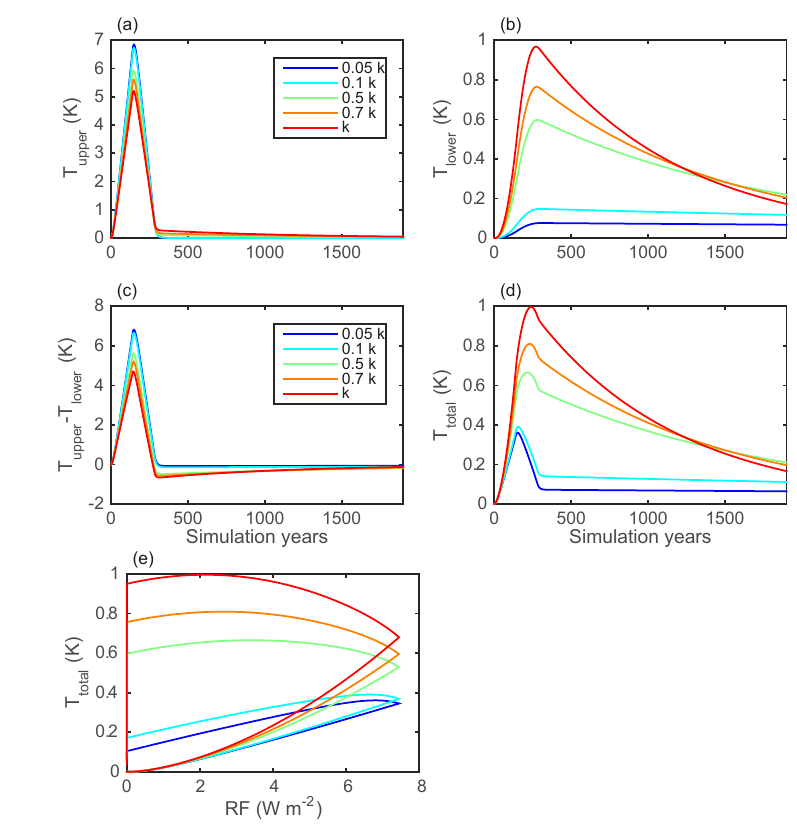
Figure 5. Temperature changes for the two-layer model: change in upper ( T upper ) (a) and lower layer temperature T lower (b) , difference in the temperature between the layers (c) , change in total temperature ( d , calculated as average of T upper and T lower weighted by the layer depth), and change in total temperature versus radiative forcing (e) . k = 1cm 2 s − 1 is the thermal diffusivity between the